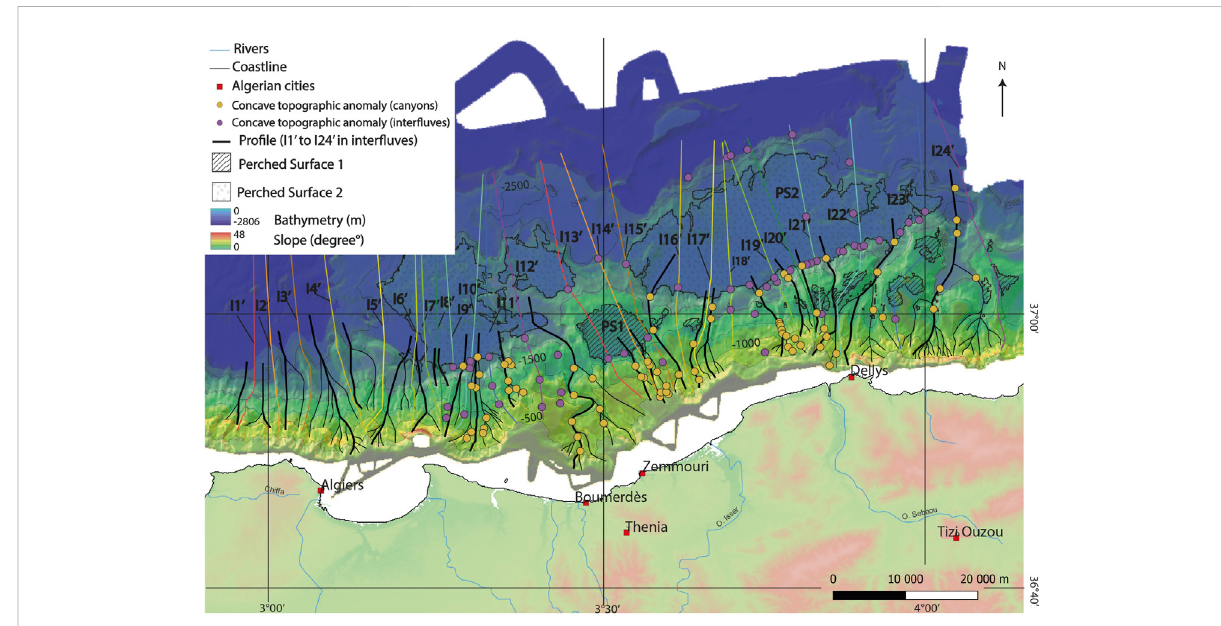
FIGURE 5 Map of classi fi ed bathymetry and of longitudinal pro fi les outside canyons and gullies (inter fl uvial positions) in the area off Boumerdès (colored lines). Yellow and purple circles refer to main knickpoints identi fi ed in the canyons and the inter fl uves respectively. I1 ′ to I24 ′ are the 24 longitudinal pro fi les between canyons (inter fl uves) and gullies (Figure 6). Black lines are the canyons and